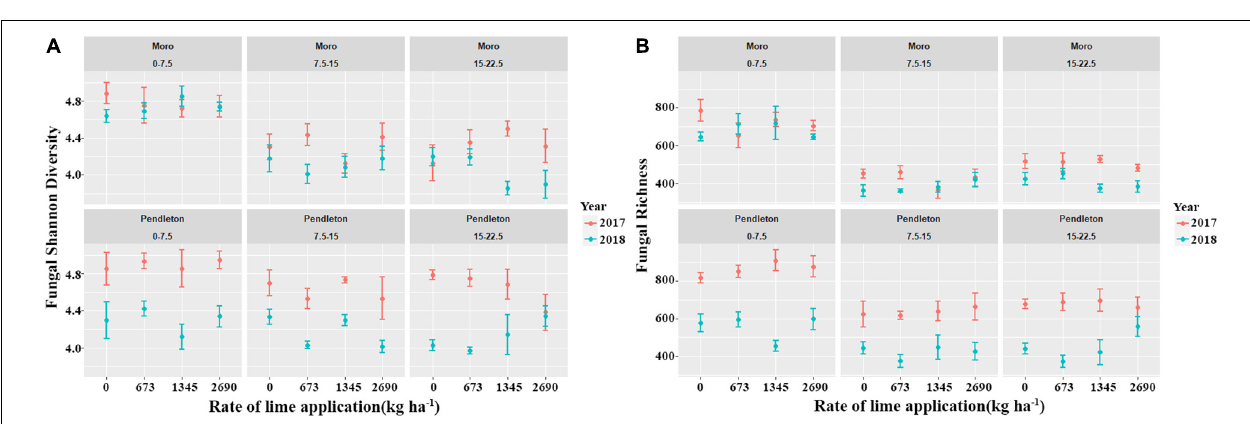
FIGURE 2 | Fungal diversity and richness indices among locations, soil depth, years, and lime applications. (A) Fungal Shannon diversity. (B) Fungal richness ( p ≤ 0.05, Kruskal-Wallis